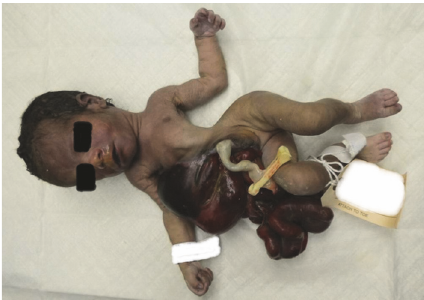
Figure 2: Gastroschisis is shown; note the fact that the defect is to the right of the umbilical cord and the liver and bowel are not covered by a sac. Note significantly damaged bowel with evidence of matting, foreshortening, and peel.